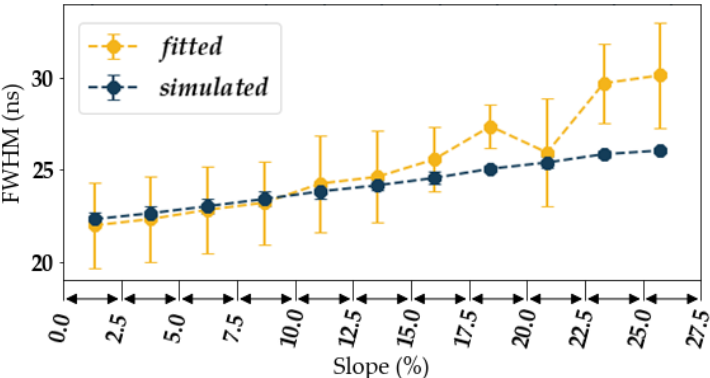
Figure 12. Difference between the mean FWHM of simulated and fitted ground return by slope class. The vertical bars represent one standard deviation.